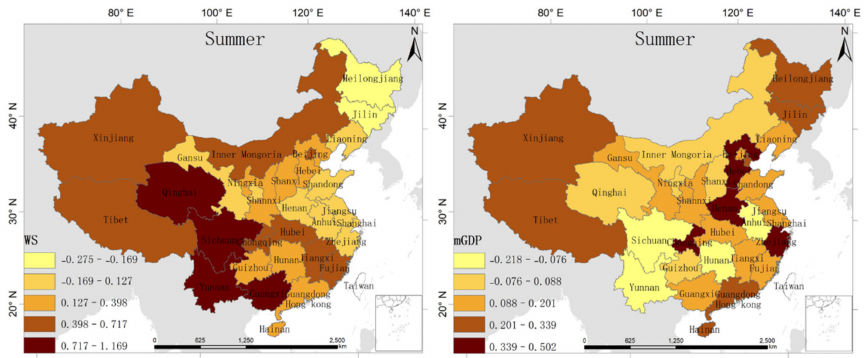
Figure 5. The spatial variations of the coefficients of the GWR model in